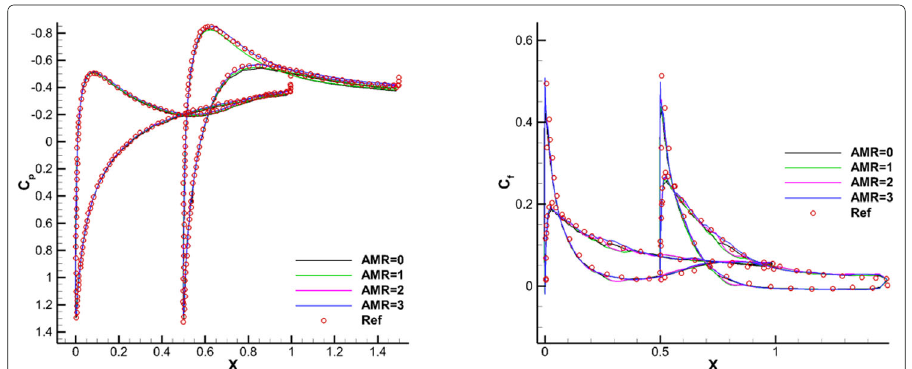
Fig. 18 Simulated results obtained with different levels of refinement for the viscous flow over two staggered NACA0012 airfoils. Left: pressure coefficient. Right: skin-friction coefficient